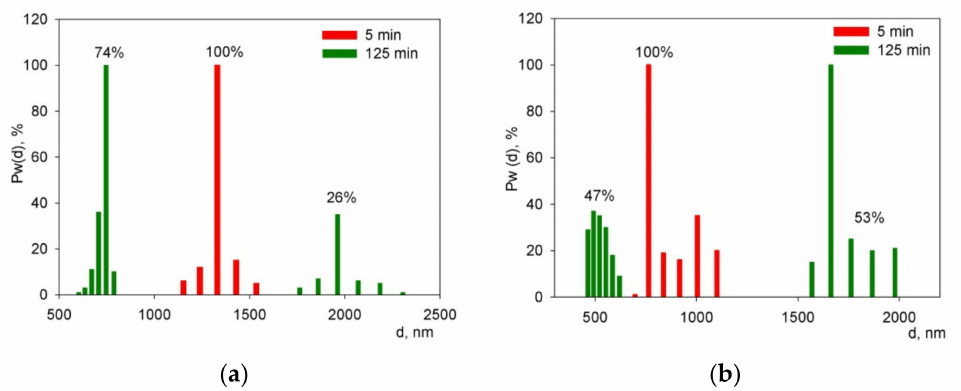
Figure 5. Fractional composition after the ultrasonic treatment for 5 and 125 min in suspensions: ( a ) the BCZYYbO-CuO; ( b ) SDC. P w (d) is a weight fraction (%) of aggregates with a diameter d (nm).